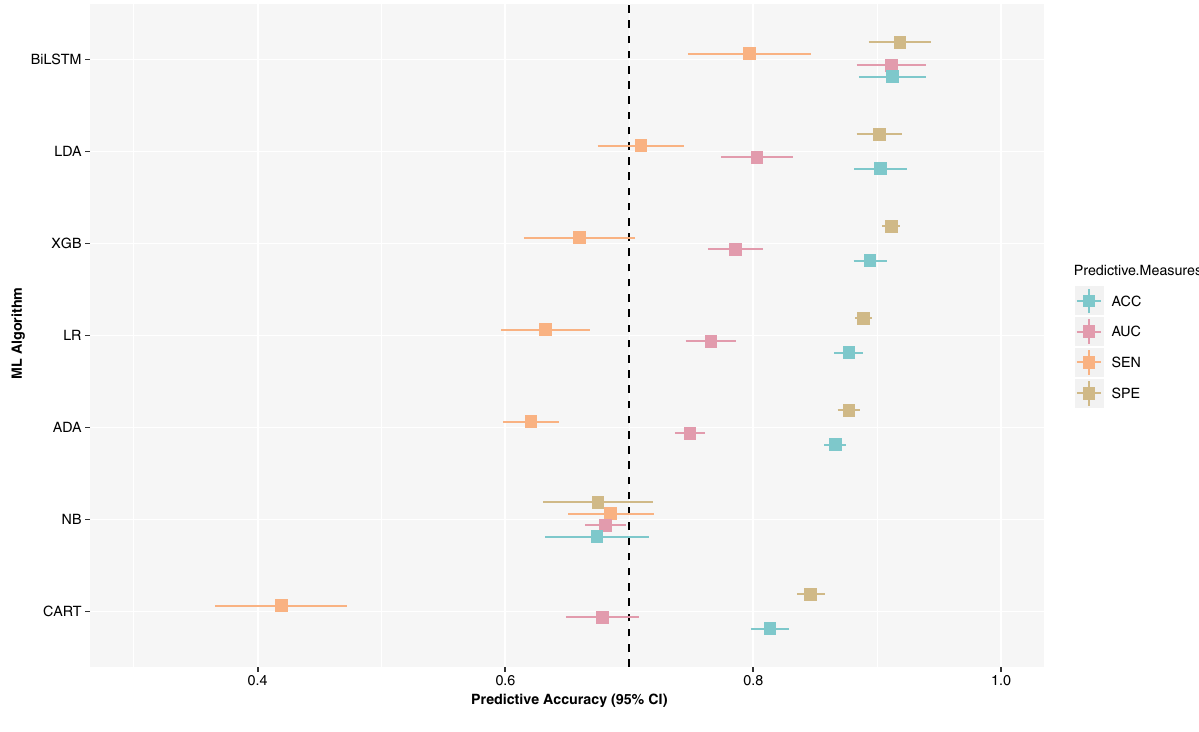
Figure 5. Overall performance of ML